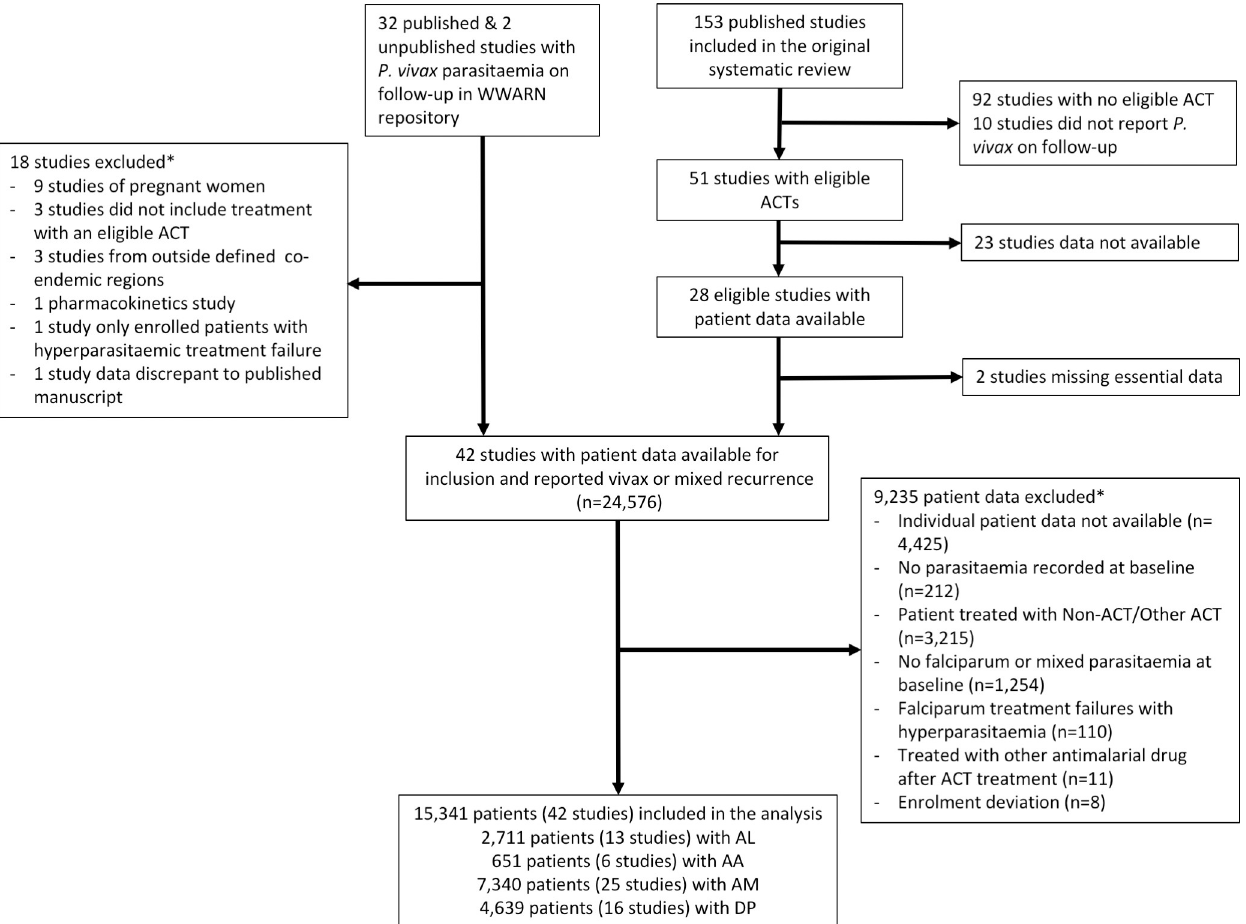
Fig 1. Study flowchart. AA, artesunate-amodiaquine; ACT, artemisinin-based combination therapy; AL, artemether-lumefantrine; AM, artesunate- mefloquine; DP, dihydroartemisinin-piperaquine; WWARN, WorldWide Antimalarial Resistance Network.